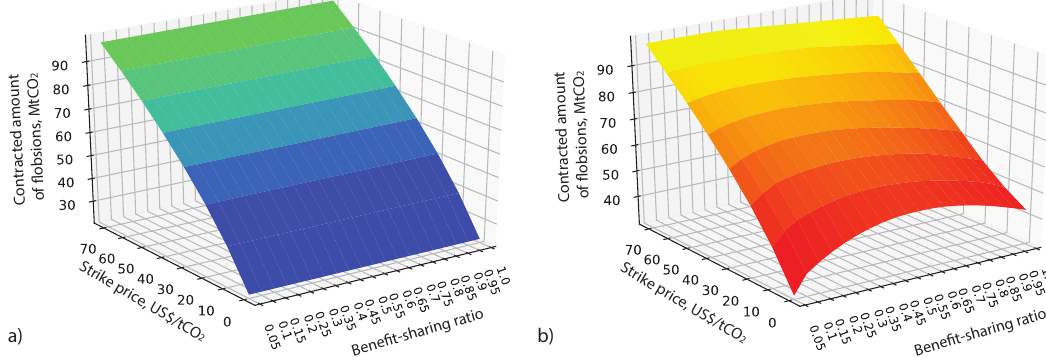
Figure 6. Contracted amounts of flobsions with respect to benefit-sharing ratio, δ ∈ [ 0.05,1 ] and strike price p min ∈ [ 0,70 ] : ( a ) risk-neutral case N, ( b ) risk-averse case A3. CO 2 distribution (19) and opportunity cost (20) with K =